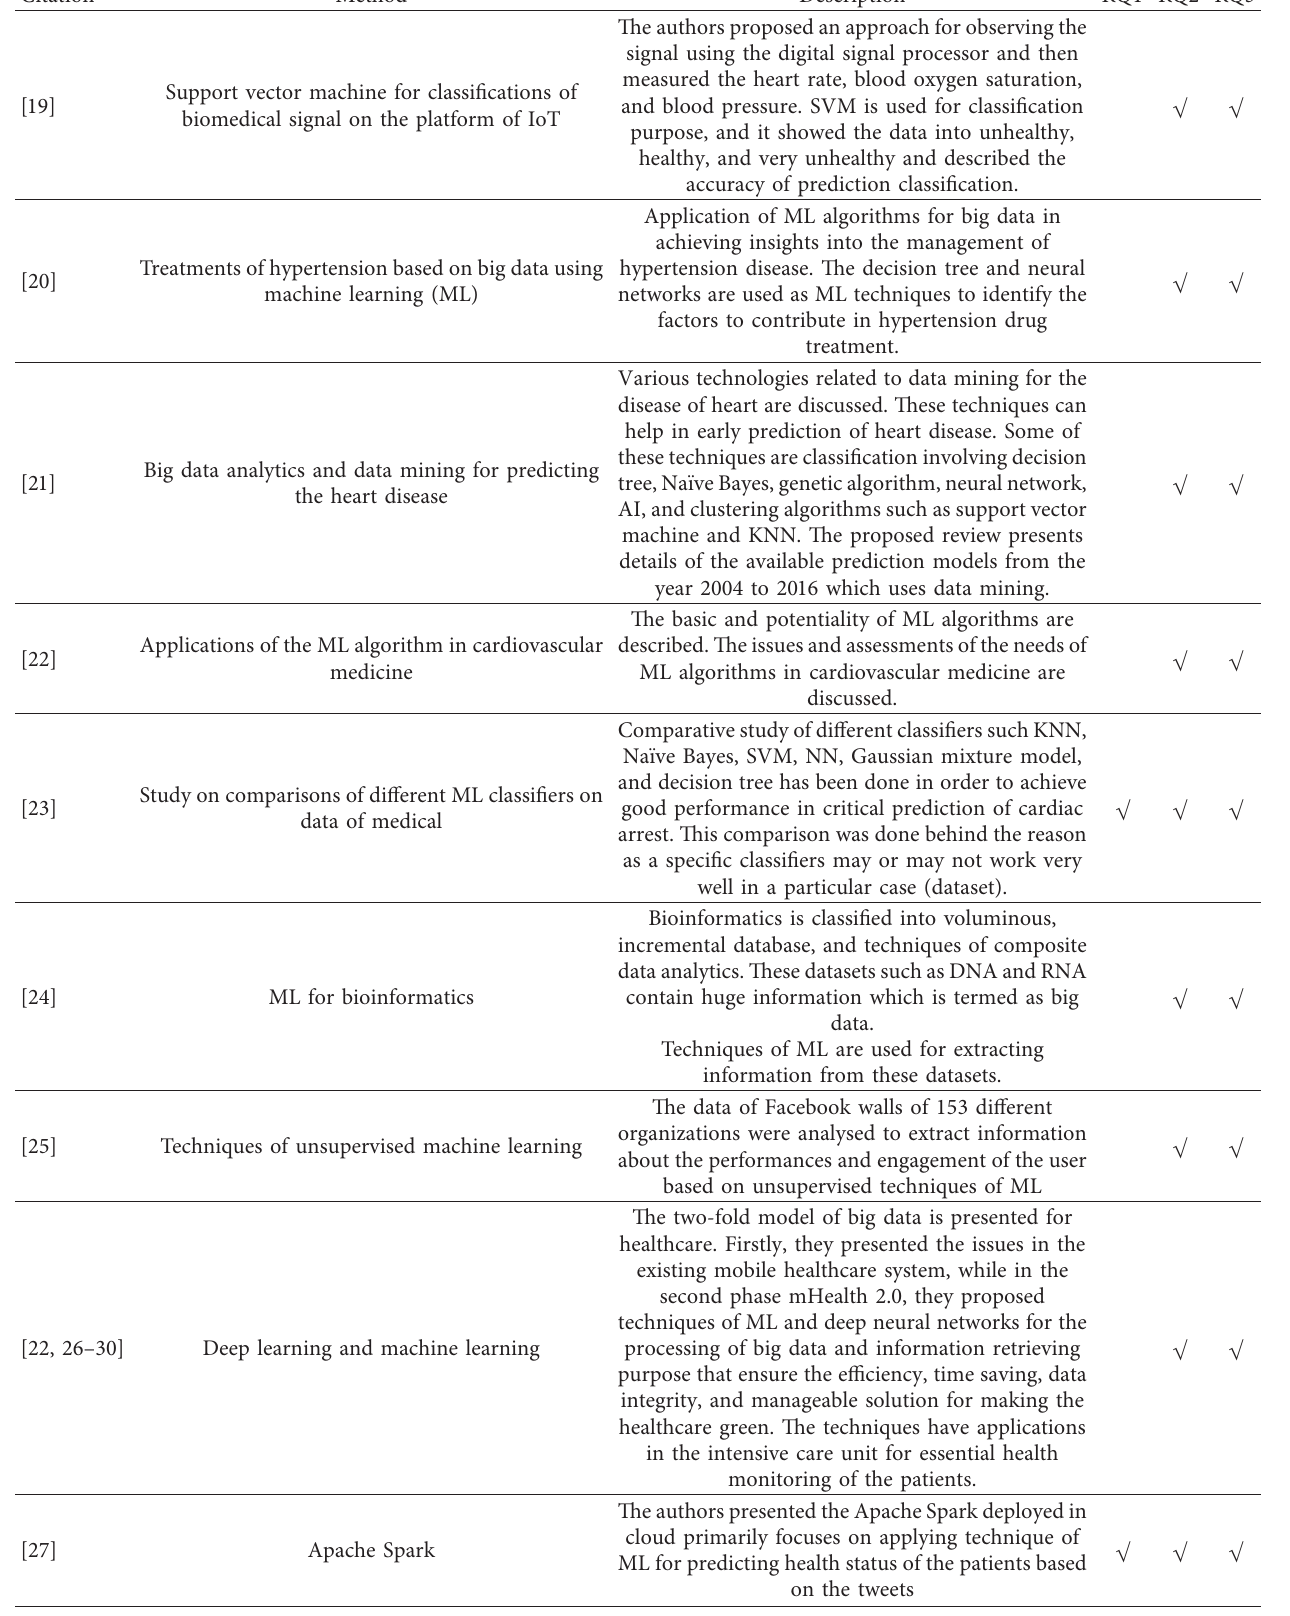
Table 2: Details of the answers to the research question defined for the proposed research.